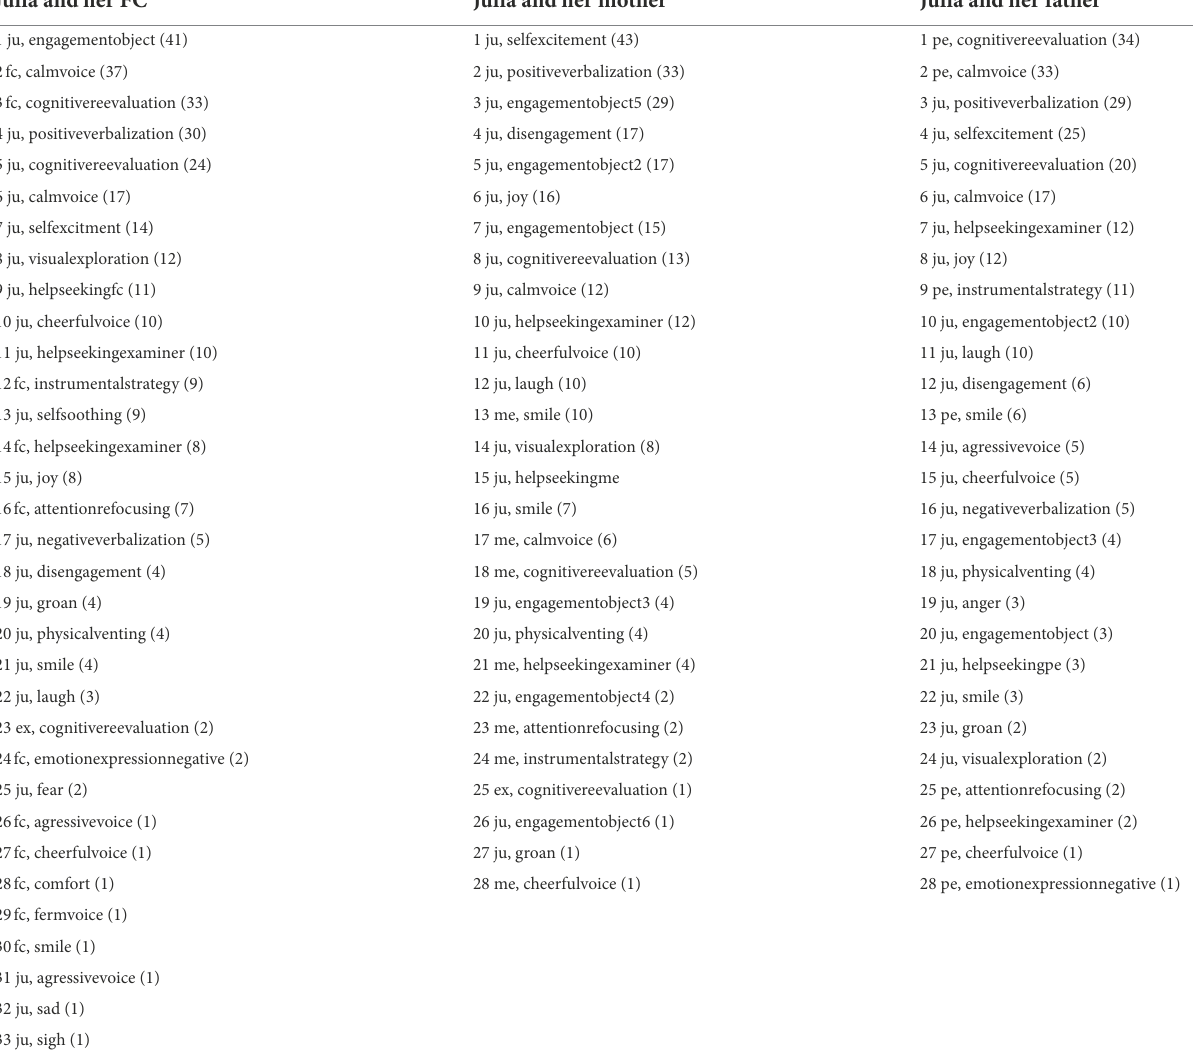
TABLE 2 Occurrences of behaviors for each interaction. Julia and her FC Julia and her mother Julia and her